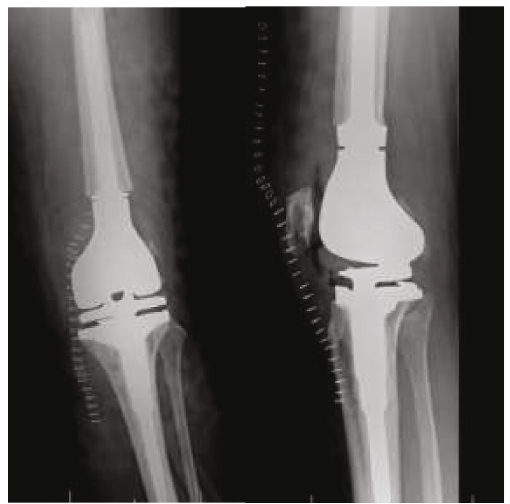
Figure 4: Immediate postoperative radiographs following hinged distal femoral